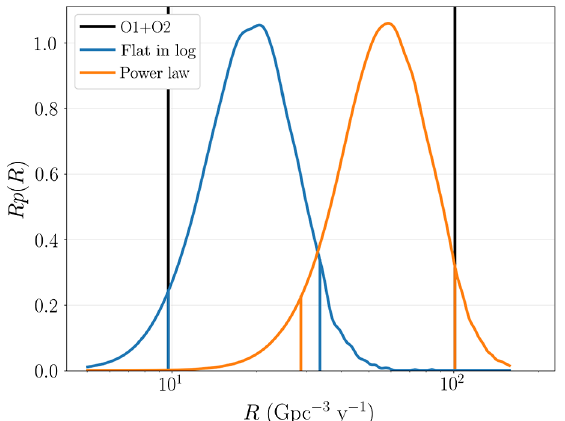
combined from the results of PyCBC and GstLAL — on the BBH event rate for the flat in log (blue) and power-law (orange) mass distributions. The symmetric 90% confidence intervals are indicated with vertical lines beneath the posterior distribution. The union of intervals is indicated in